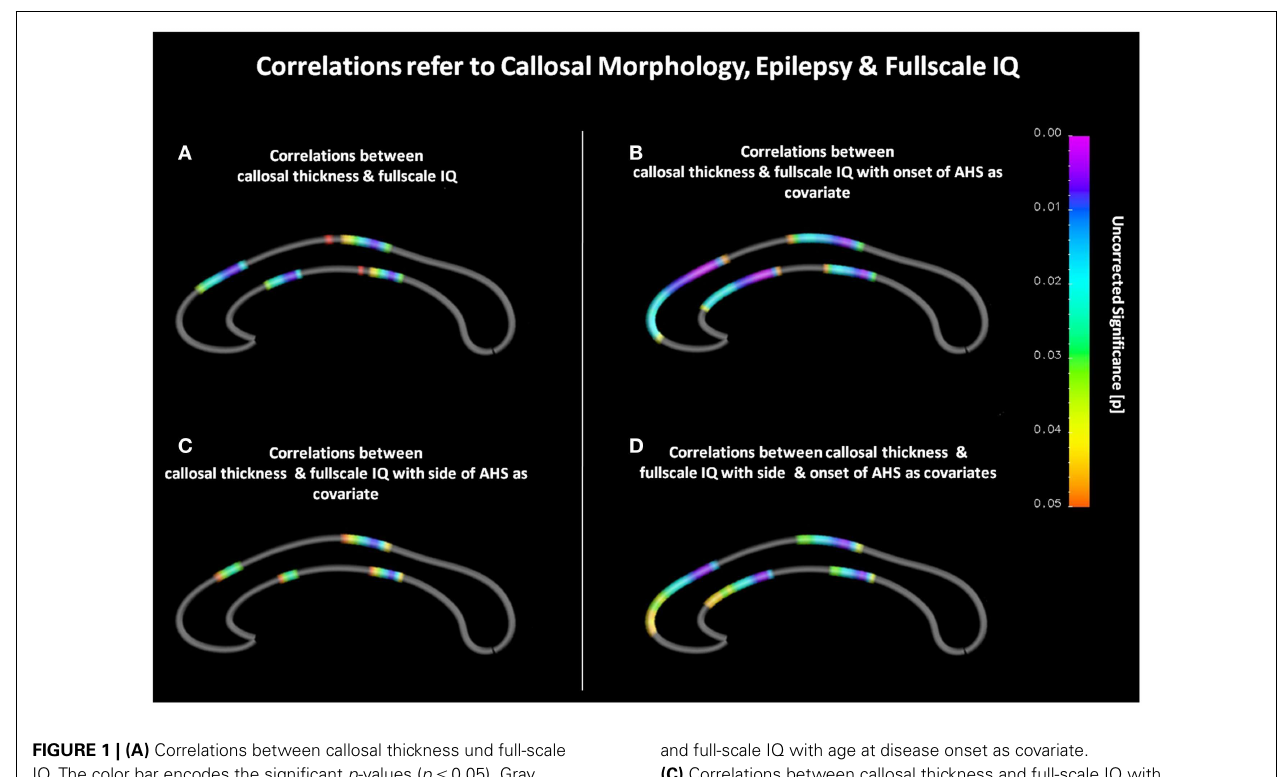
FIGURE 1 | (A) Correlations between callosal thickness und full-scale IQ.The color bar encodes the significant p -values ( p ≤ 0.05). Gray color indicates where no significant correlations were detected.The anterior callosal region is located on the left, the posterior callosal region points to the right. (B) Correlations between callosal thickness